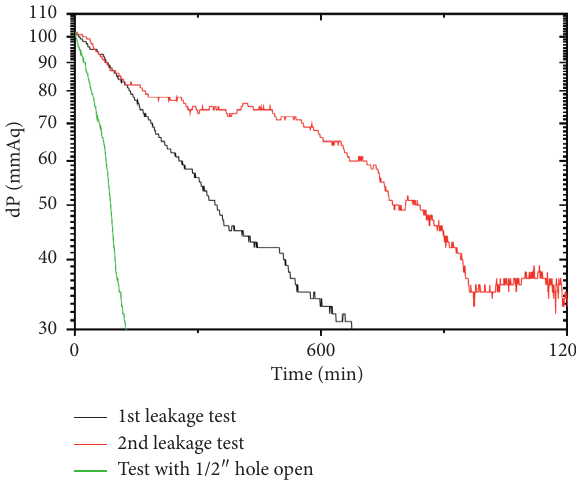
Figure 7: Leakage test result for argon cell [23].